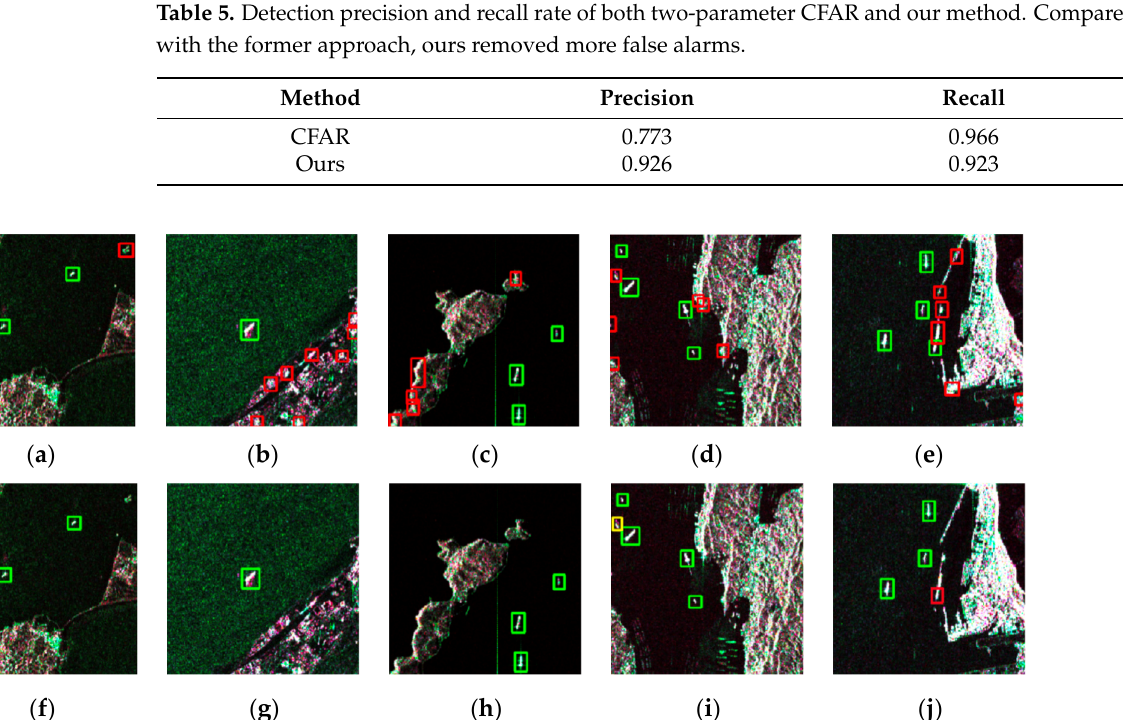
Figure 19. Visualization of reconstruction results. ( a – c ) are comparison of real ship chips on the left and images restored from MemAE on the right. On the left of ( d – f ) are false alarms and on the right are the corresponding reconstructions.